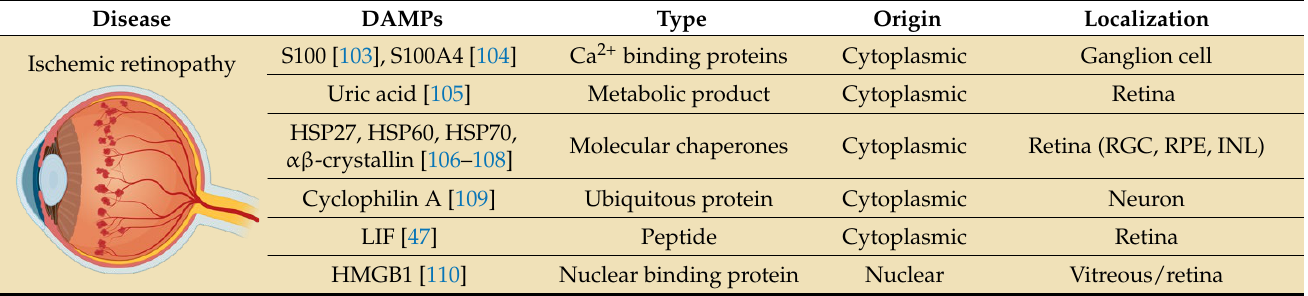
Table 5. DAMPs in ischemic retinopathies.